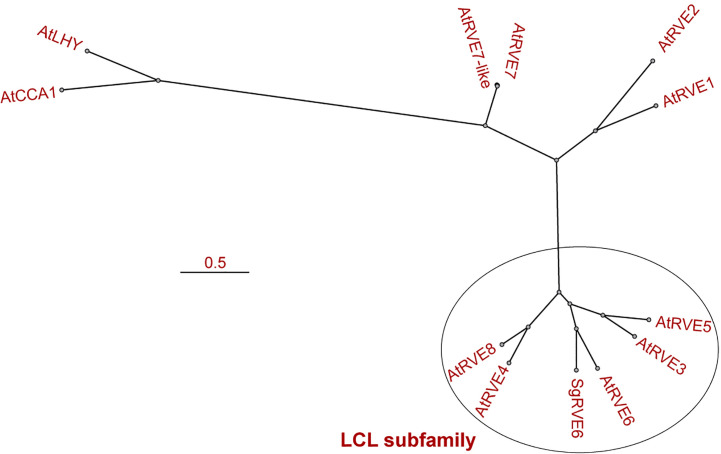
Phylogenetic analysis of the eleven members of the Arabidopsis thaliana RVE family and SgRVE6. T-Coffee was used for the multiple alignment and MrBayes for the tree construction. The oval delimits the members of LHY/CCA1-LIKE (LCL) subfamily. The scale bar represents the number of nucleotide substitutions per site.